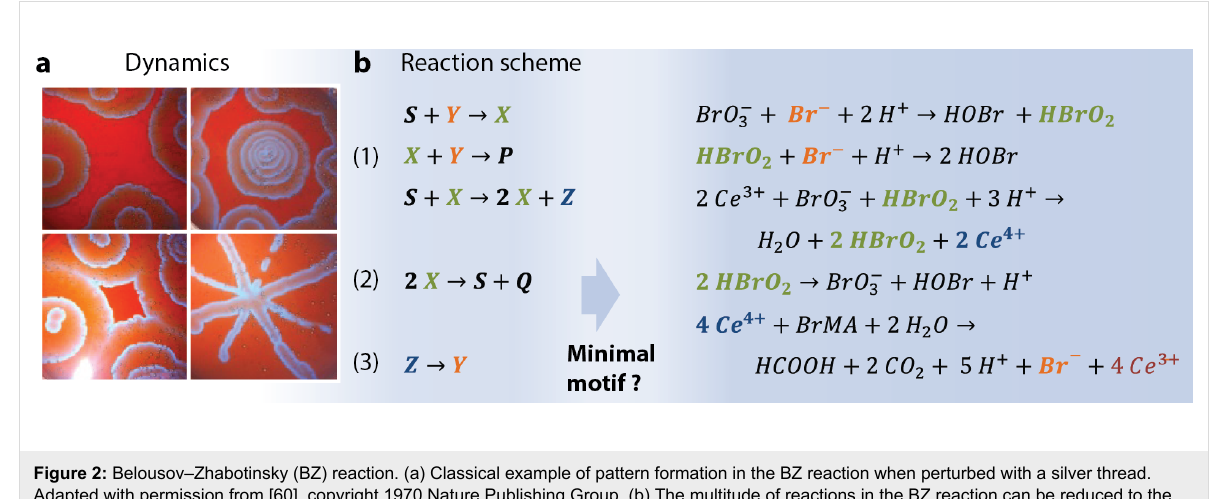
Figure 2: Belousov–Zhabotinsky (BZ) reaction. (a) Classical example of pattern formation in the BZ reaction when perturbed with a silver thread. Adapted with permission from [60], copyright 1970 Nature Publishing Group. (b) The multitude of reactions in the BZ reaction can be reduced to the Oregonator, a three-variable scheme (with key species X = HBrO 2 , Y = Br − , and Z = Ce 4+ ) [68,69].